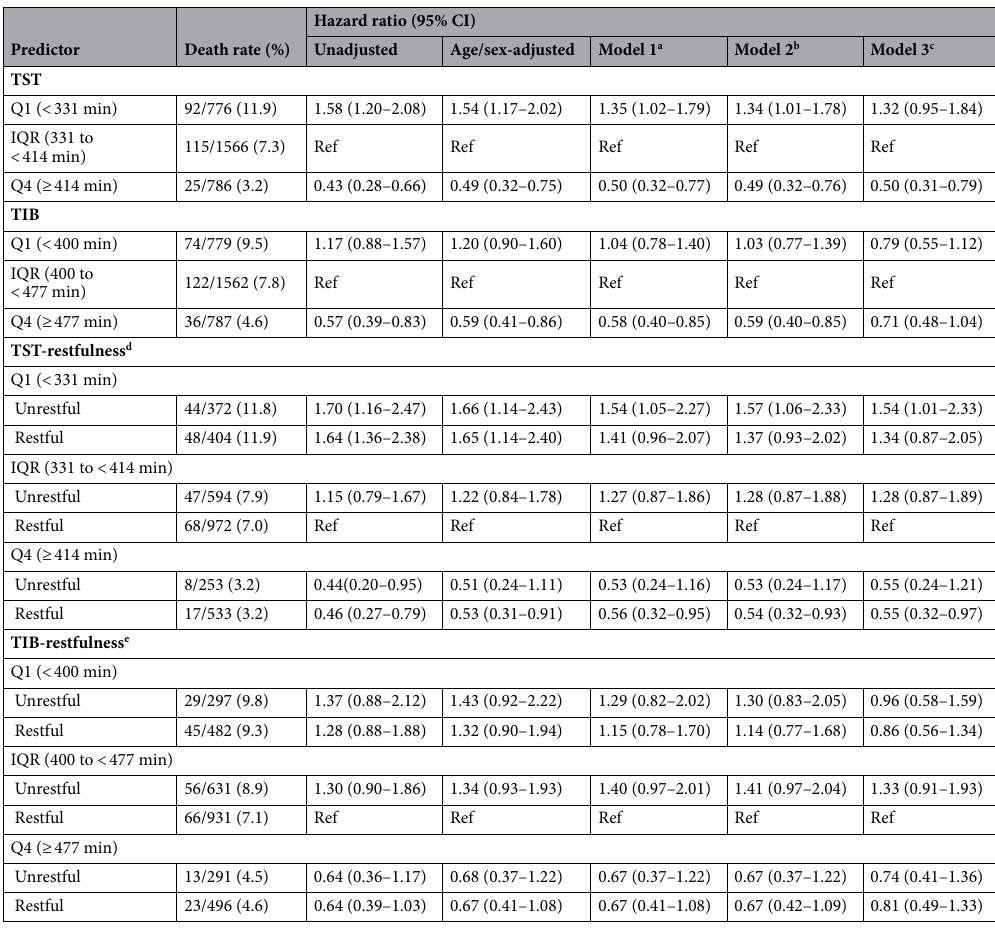
TIB-restfulness categories did not capture high-risk populations. Thus, sufficient objective TST and subjective restorative sleep might be vital in promoting health in middle-aged adults.